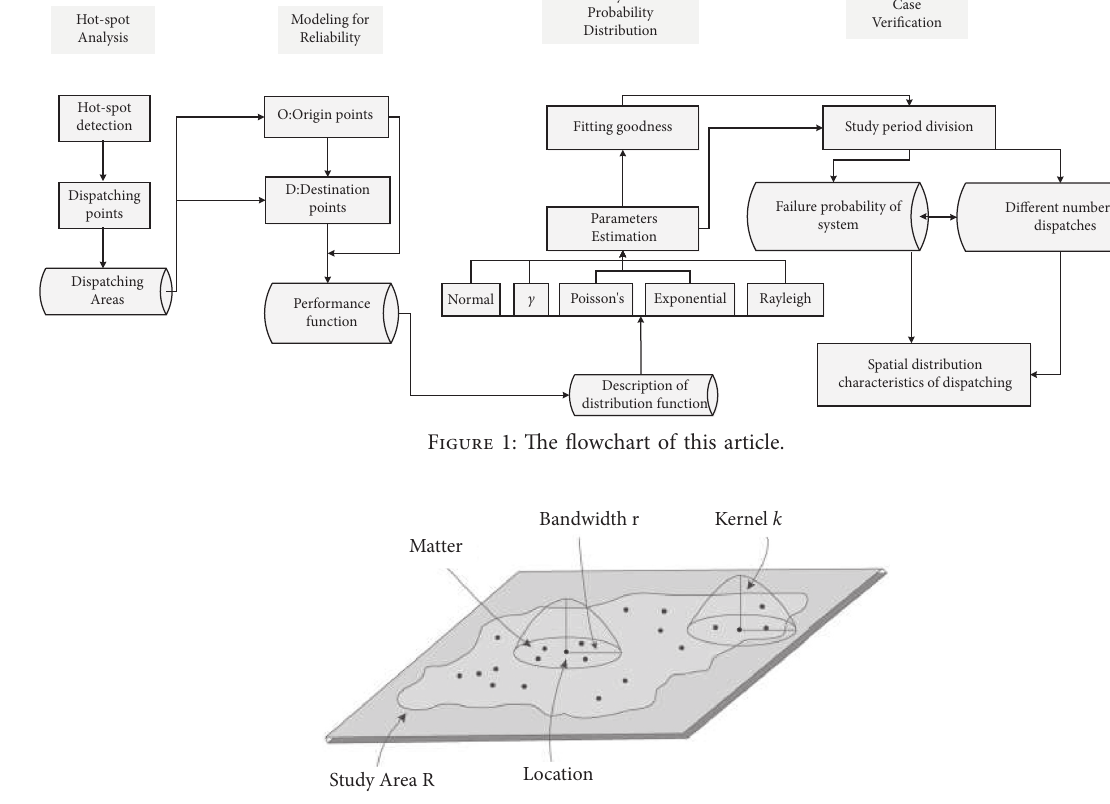
Figure 2: The model of kernel density